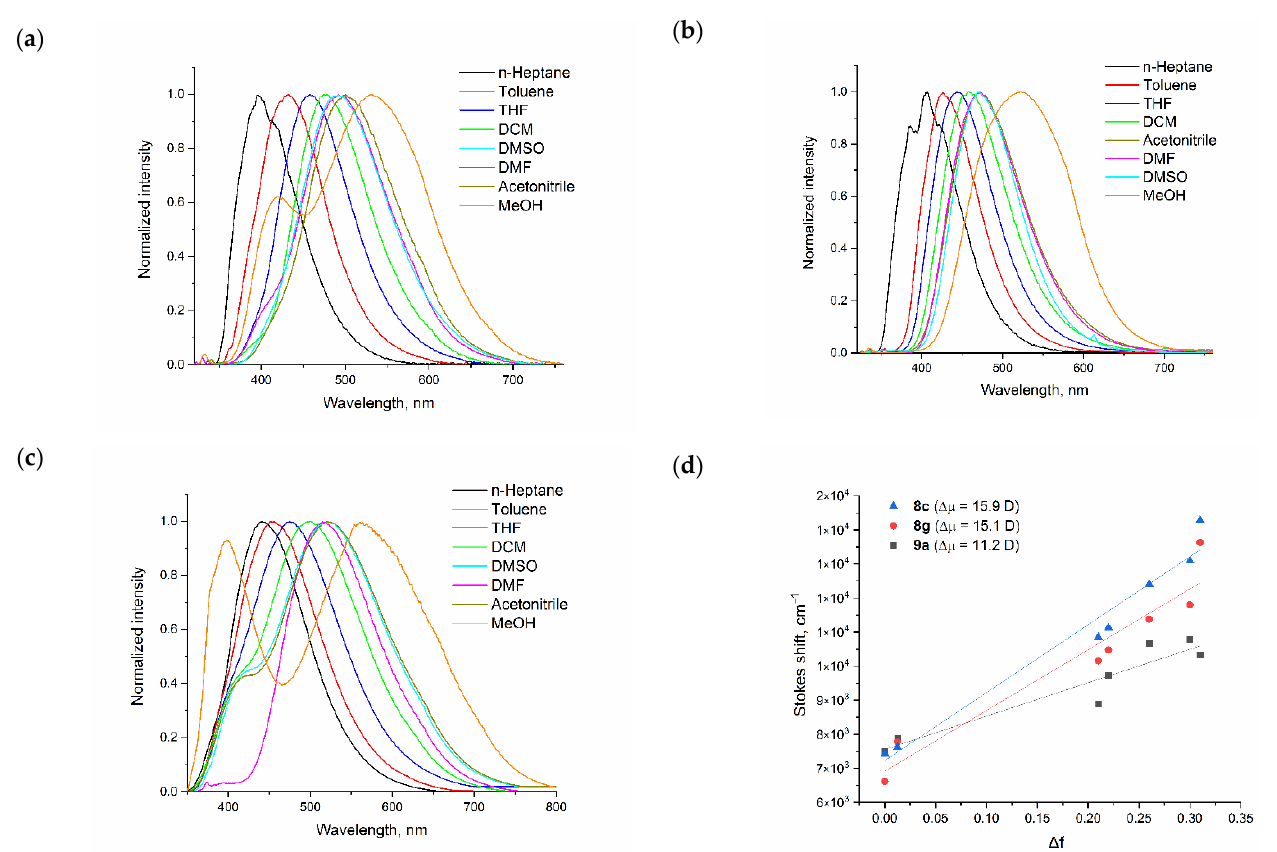
Figure 7. Normalized fluorescence spectra of 8c ( a ), 8g ( b ), and 9a ( c ) in different solvents (C = 10 − 5 M − 1 ); ( d ) Lippert-Mataga Plots for compounds 8c , 8g , and 9a in n-heptane, toluene, THF, DCM, DMF, MeCN, and MeOH. Slopes: 19,962 in 8c , 17,850 in 8g , and 9814 in 9a . Goodness of fit parameter, R 2 : 0.97 in 8c , 0.93 in 8g , and 0.90 in 9a (ESI).